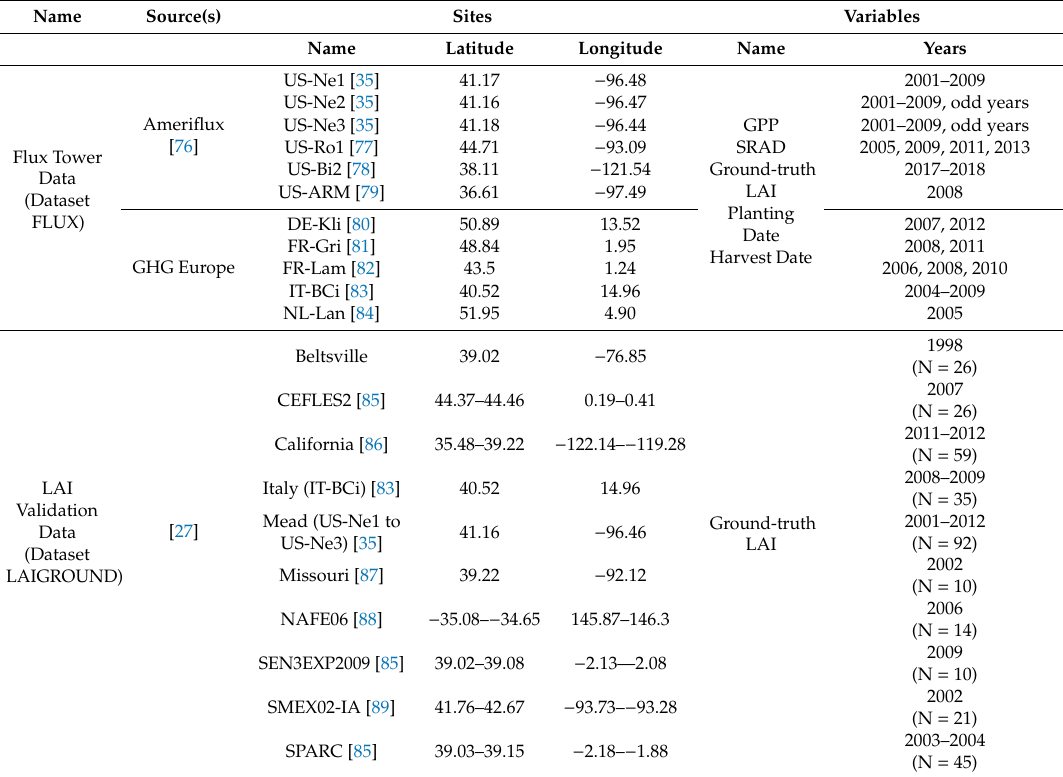
Table 2. Ground-truth data